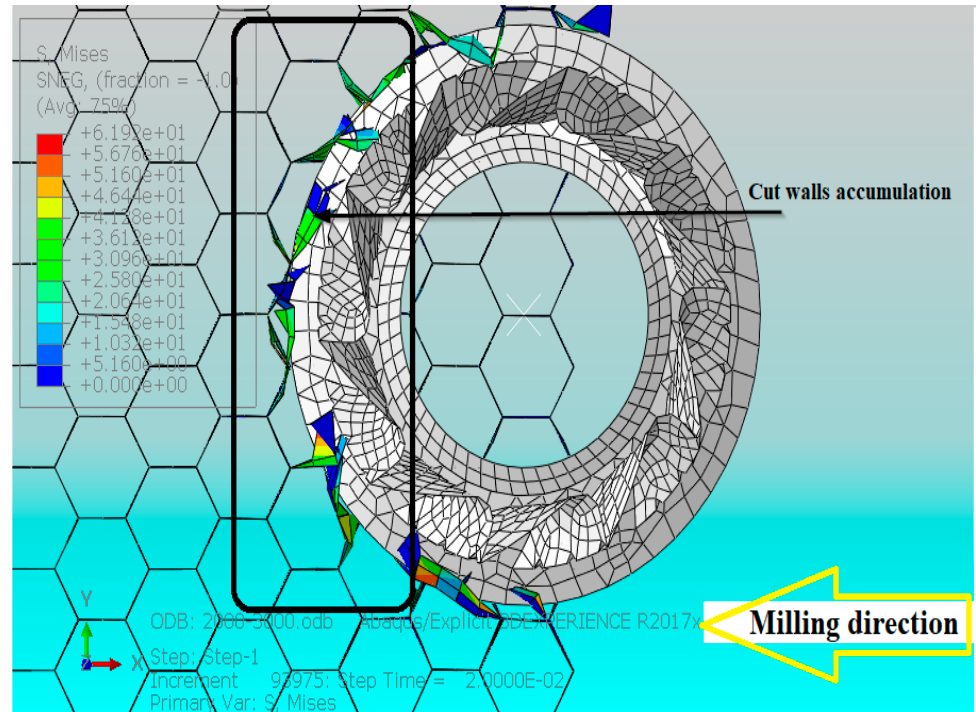
Figure 23. Accrual of material in the face of the cutting tool; wedge angle of the cutting blade is β n = 30°.